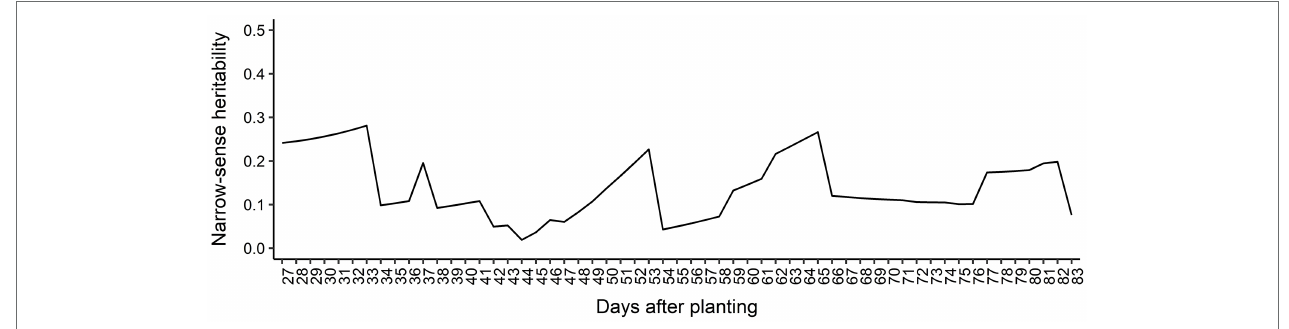
FIGURE 3 | Narrow-sense heritability estimated for each day after planting.